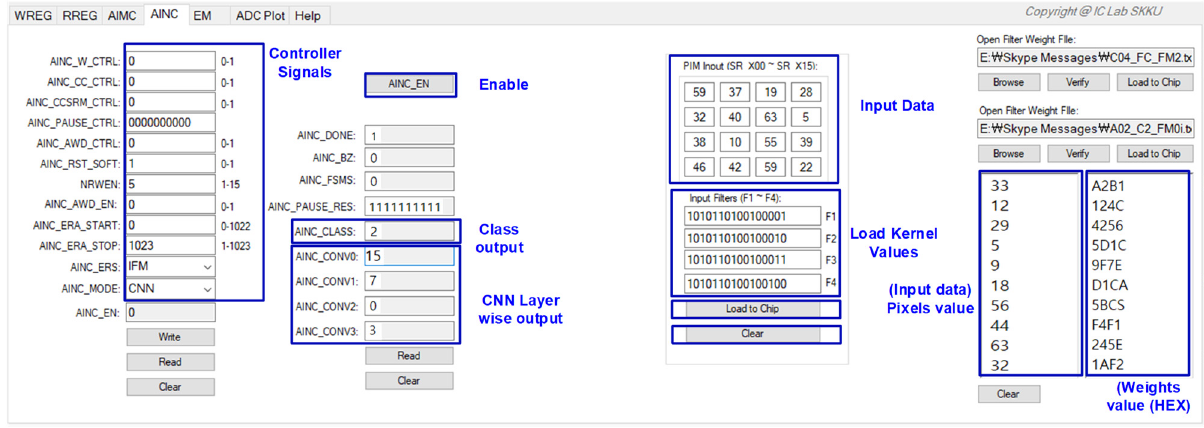
Table 2. Performance comparison with related works .